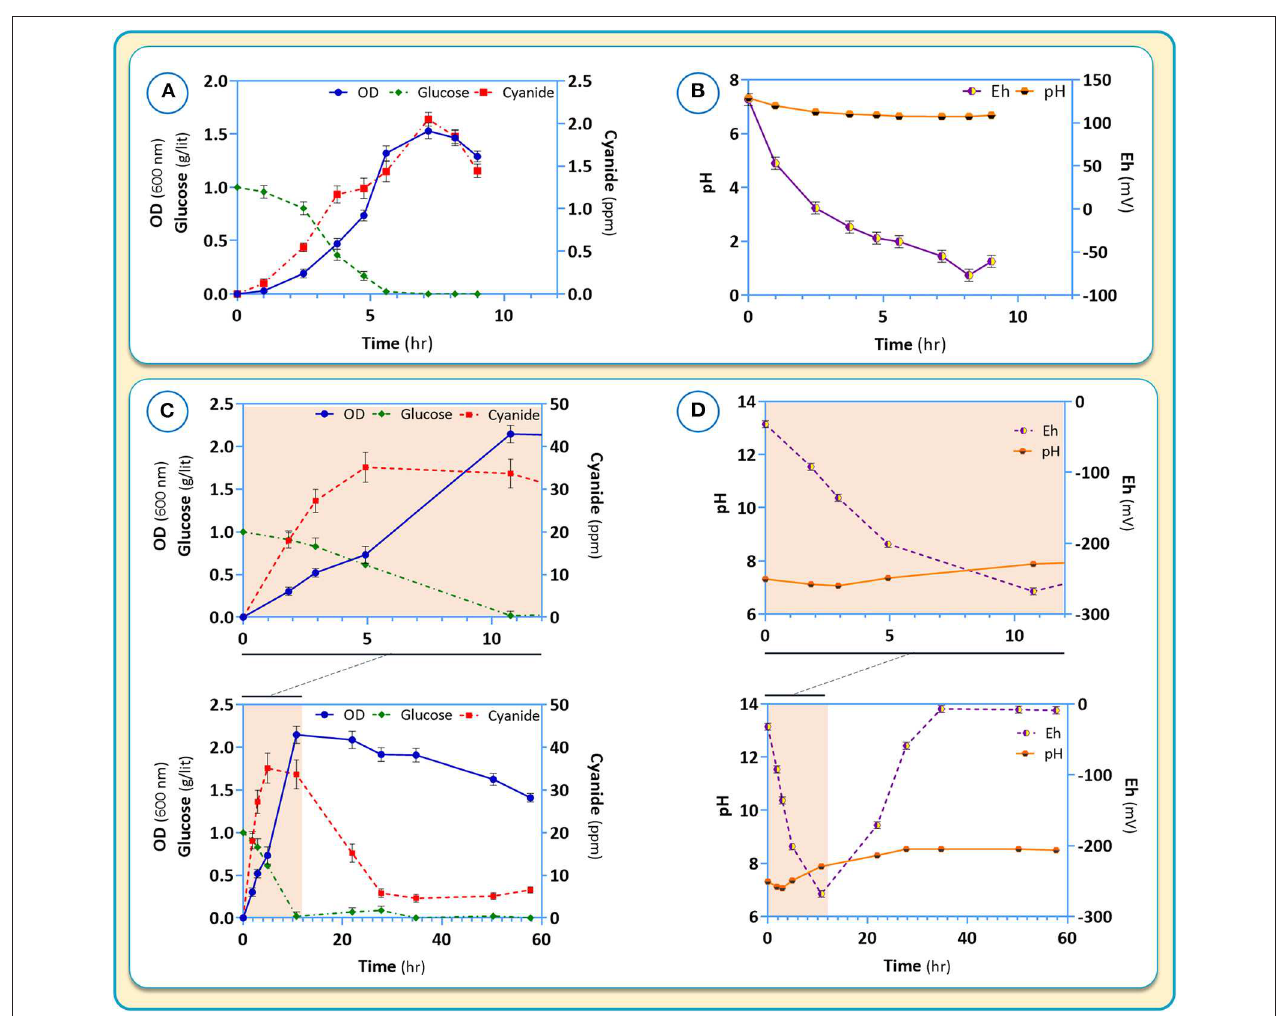
FIGURE 9 | Growth characteristic (A,C) and pH as well as Eh (B,D) changes for B. megaterium DSM319 in different culture media: (A,B) CDM2 and (C,D) CDM2 + cysteine (2 θ µ M).